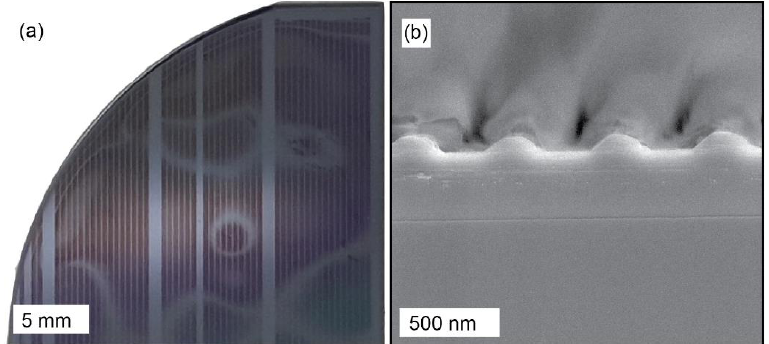
Figure 2. Grating lithography ( a ) a quarter two-inch InP-based QCL wafer with a lithography resist for a grating. The resist pattern is disrupted by Newton’s rings; and ( b ) cross-sectional SEM micro graph of the grating lithography after wet etching with a low-end feature size of ~260 nm. Starting from an active region layer, the first step in an iBH process [34] for single-mode devices is the photolithographic definition and wet-chemical etching of the DFB grating (Figure 2a). For short